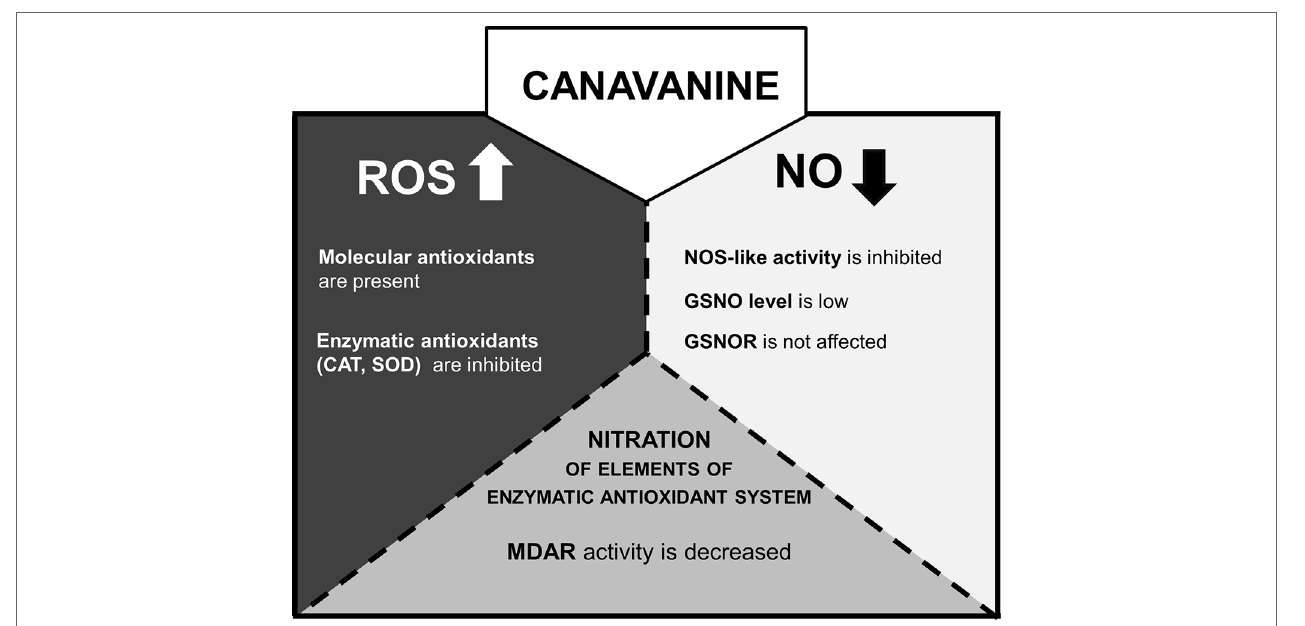
FIGURE 7 | The model of CAN action in tomato roots after prolonged (72 h) supplementation of seedlings with the NPAA. CAN increases level of ROS (Krasuska et al., 2016a) and decreases NO emission (Krasuska et al., 2016a). ROS are accumulated (CAN secondary mode of action) and could inhibit GSNOR activity by oxidative PTMs (Lindermayr, 2018). However, the gene expression and activity of GSNOR are not affected. GSNO level is lowered probably due to limitation of NO resulting from restriction of NOS-like activity (direct mode of action of CAN). ROS over-accumulation is accompanied by stimulation of molecular antioxidant system. CAT or SOD gene expression is downregulated, CAT and SOD enzymatic activities are inhibited. MDAR is an enzymatic antioxidant and the target of differential nitration in CAN-supplemented